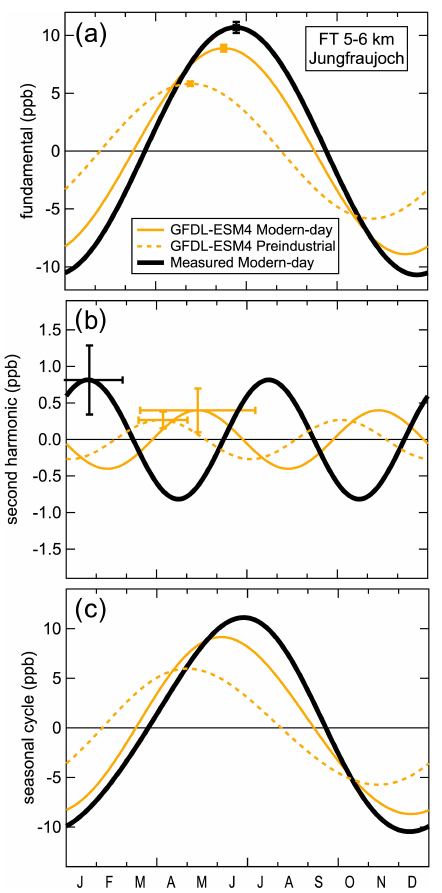
Figure 4. Comparison of simulated preindustrial and modern-day seasonal cycles in the FT between 5 and 6km above Jungfrau- joch; the observed modern-day seasonal cycle is also included. The GFDL-ESM4 simulations are the same as shown in Figs. 1 and 2. The preindustrial seasonal cycle is the same as included in Fig. 3, and the format is also the same as that figure: panel (a) shows the fundamental frequency, panel (b) shows the second harmonic and panel (c) shows the sum of the two harmonics. The modern-day seasonal cycle was calculated over the 1985–2014 period, and the measured seasonal cycle is based on the 1998–2017 European sonde